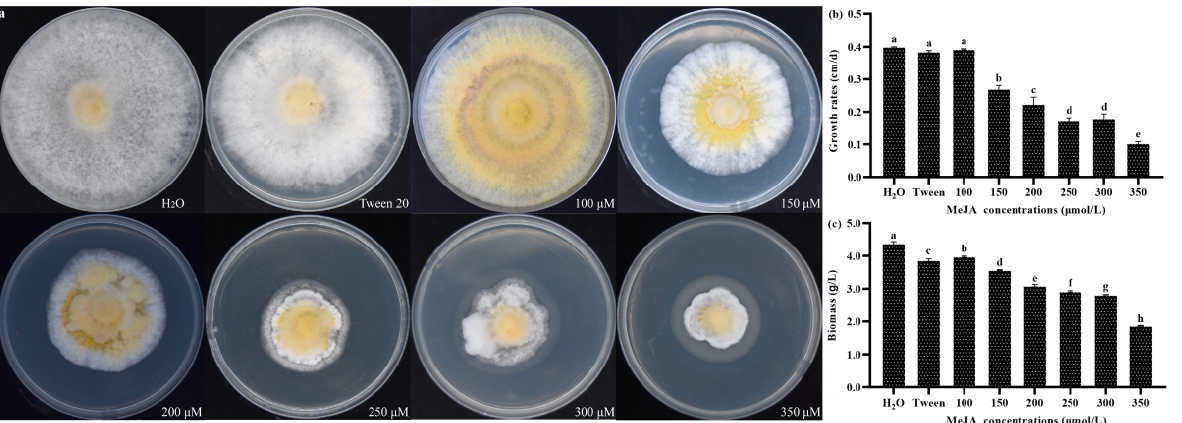
Figure 5. Growth of S. baumii colonies on PDA (potato dextrose agar) medium supplemented with different concentrations of MeJA. ( a ) Colony morphology; ( b ) growth rate; ( c ) biomass. The mean difference being significant at the 0.05 level, p < 0.05.